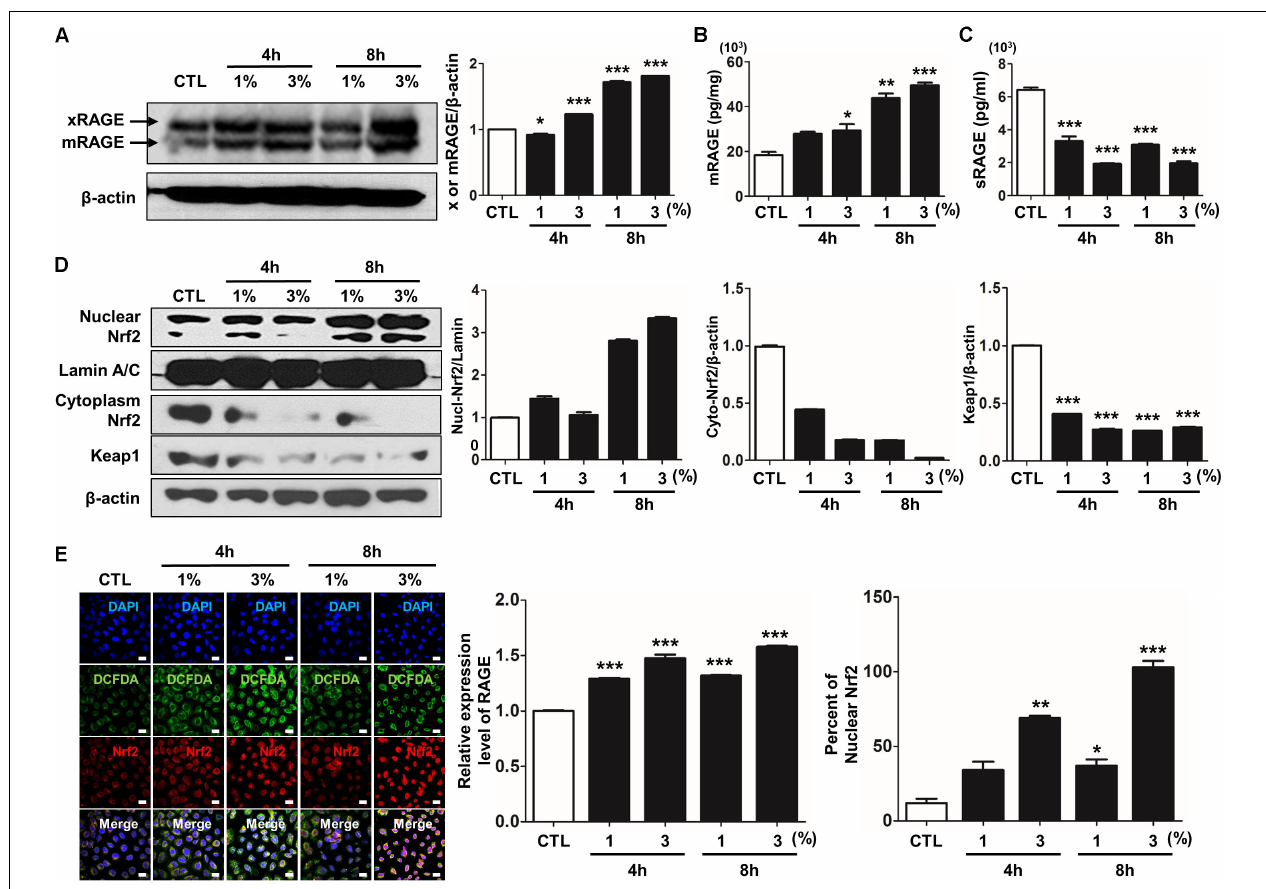
FIGURE 2 | CSE-induced alternations of RAGE distribution through Nrf2 nuclear migration in human alveolar epithelial cells. The expression level of RAGE and Nrf2-related proteins was detected in A549 cells incubated in the presence (1–3%) or absence of CSE. (A) Western blotting shows the expression levels of xRAGE and mRAGE, membrane-bound RAGE isoform in cell lysates. Net intensity of RAGE was normalized to β -actin. The levels of (B) mRAGE in lung homogenates and (C) secreting sRAGE in culture supernatants of cell after CSE exposure were detected by ELISA analysis. The concentrations of proteins were calculated based on each standard curve data. The results are represented by average value of data ( ± SE). (D) The expression of Nrf2 migration from cytoplasm into nuclear location was determined by western blot. The Lamin A/C and β -actin were used for loading control of the nuclear protein and cytoplasmic protein, respectively. (E) The confocal microscopy analysis shows the protein expression of RAGE ( green ), the localization of Nrf2 ( red ) and merged images by immunofluorescence staining. Nuclei stained with DAPI (blue). The number of RAGE-positive cells, Nrf2-postivie cells and double-positive cells chosen fields in three randomly at × 600 magnification. The results are represented by average value of data ( ± SE). CTL, no treatment. ∗ p < 0.05, ∗∗ p < 0.01, and ∗∗∗ p < 0.001 vs. CTL.